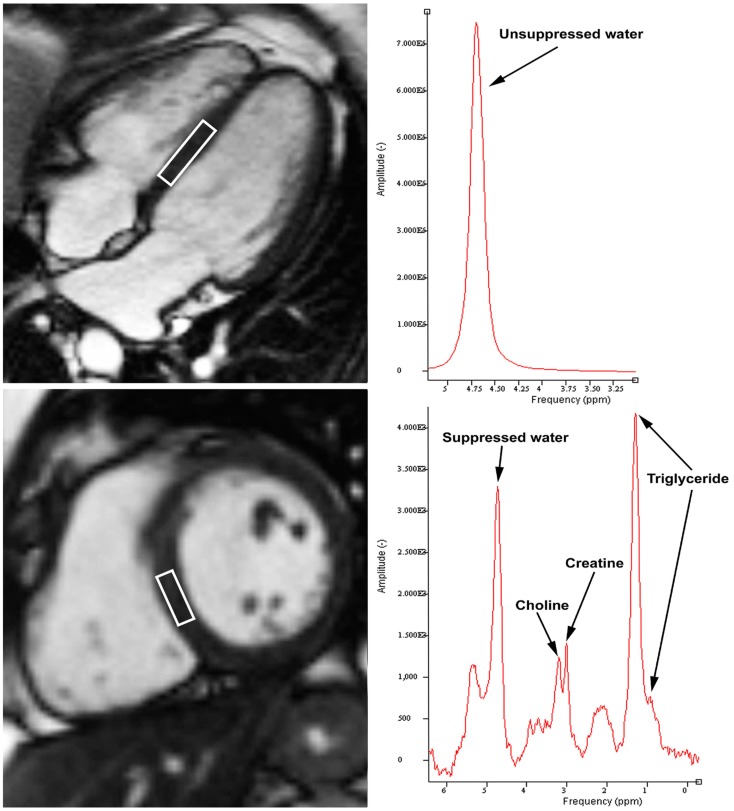
Example of cardiac proton magnetic resonance spectroscopy with voxel of interest placed at interventricular septum (left panels). Unsuppressed water content peaks at 4.7 ppm (top right panel). Intramyocardial triglyceride was quantified by summing the amplitudes of lipid resonances at 0.9 and 1.3 ppm, while choline and creatine peaks at 3.2 and 3.0 ppm, respectively (bottom right panel).